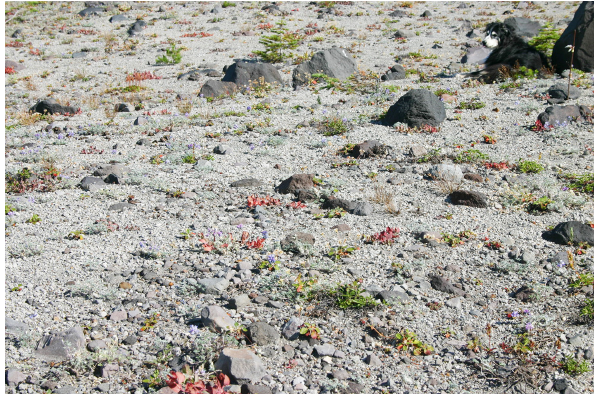
Fig. 7. Lahar deposit vegetation isolated from surviving vegetation (Photo: RdM 2004).